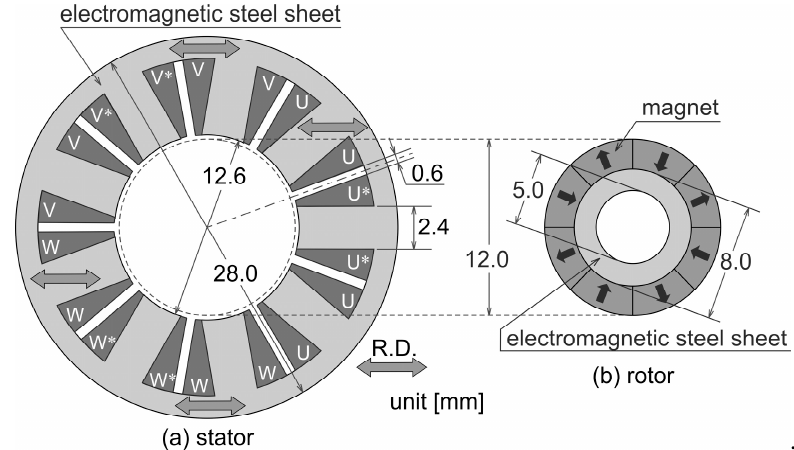
Figure 2. The base model in the stator core shape design.